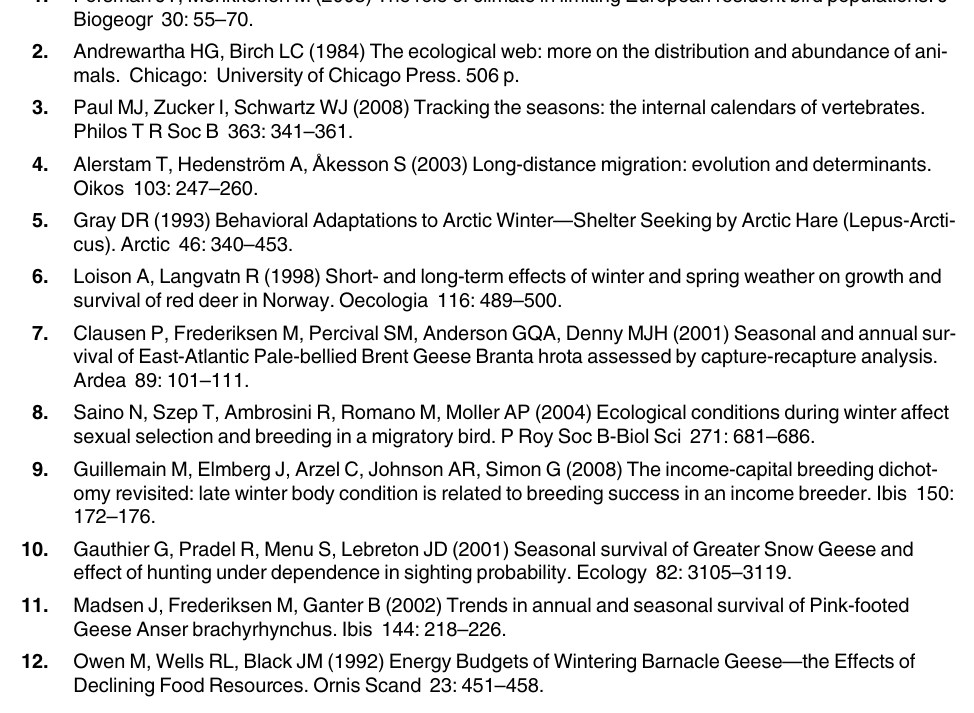
S2 Table. Ringing data for birds included in the current study.